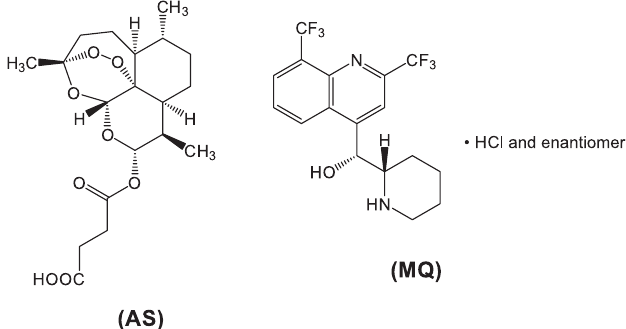
FIGURE 1 - Chemical structures of artesunate (AS) and mefloquine hydrochloride